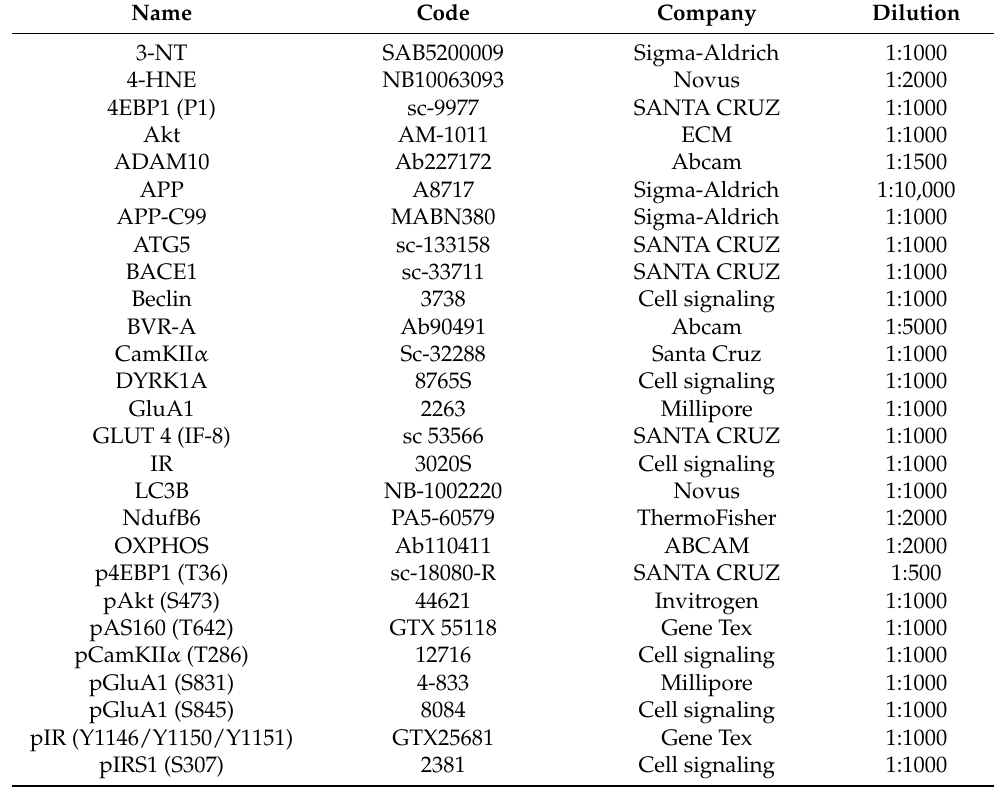
Table 1. Antibodies used in the current